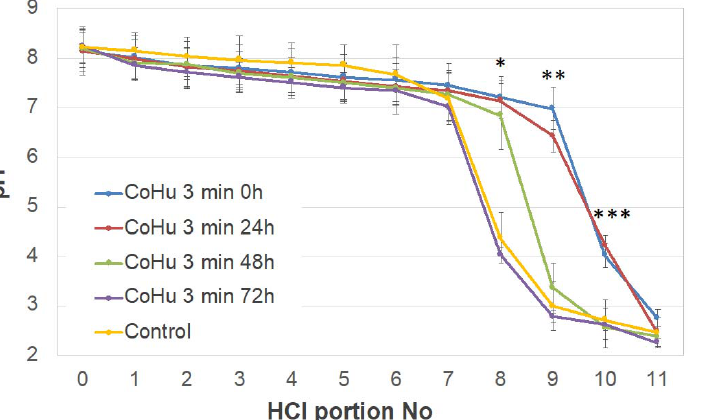
Figure 8. Averaged 0.01 M bicarbonate buffer titration curves with 0.1 M HCl. Samples were treated with CoHu for 3 min immediately before titration, 24, 48 and 72 h before titration. * p < 0.01 between control and samples that were treated with CoHu 0, 24 and 48 h before treatment; **, *** p < 0.01 between united control and samples that were treated with CoHu 48 h before treatment and samples that were treated with CoHu 0 and 24 h before treatment.